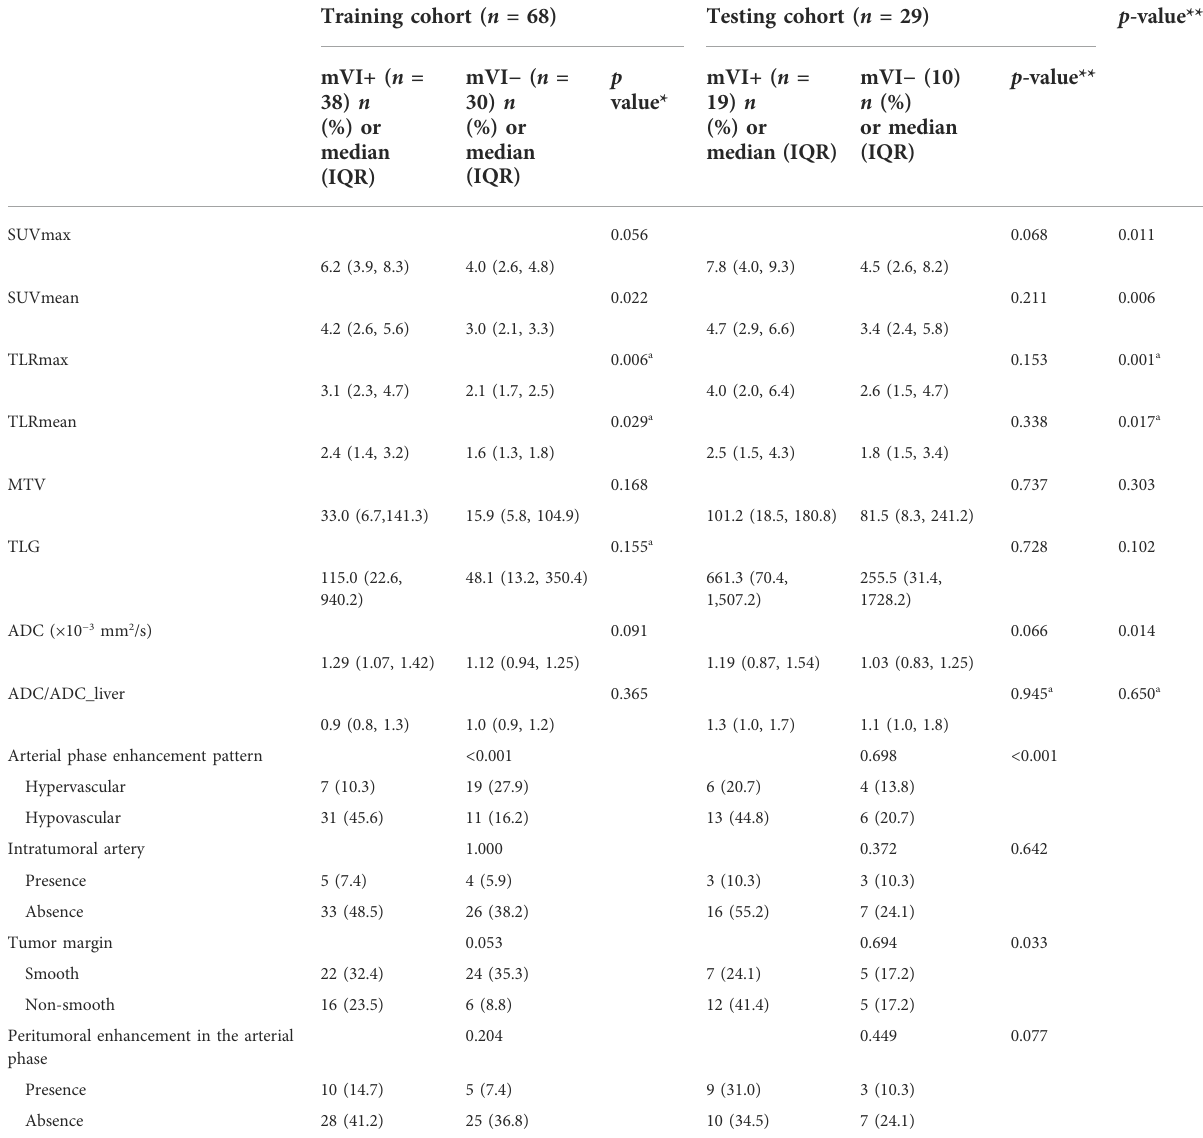
TABLE 2 Radiologic fi ndings of primary HCC in the training and testing